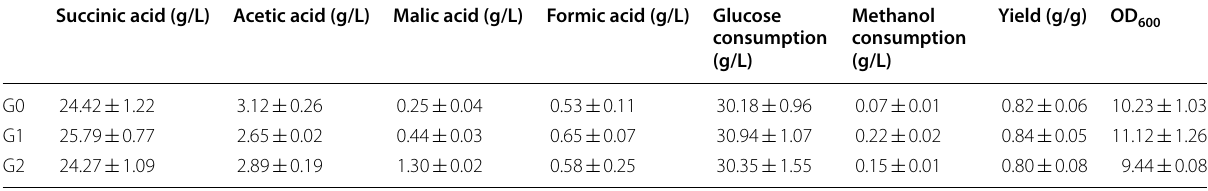
Table 2 Effects of introducing NAD + -dependent Mdhs on cell growth and fermentation performance in strain G0, G1, and G2 Succinic acid (g/L) Acetic acid (g/L) Malic acid (g/L) Formic acid (g/L) Glucose